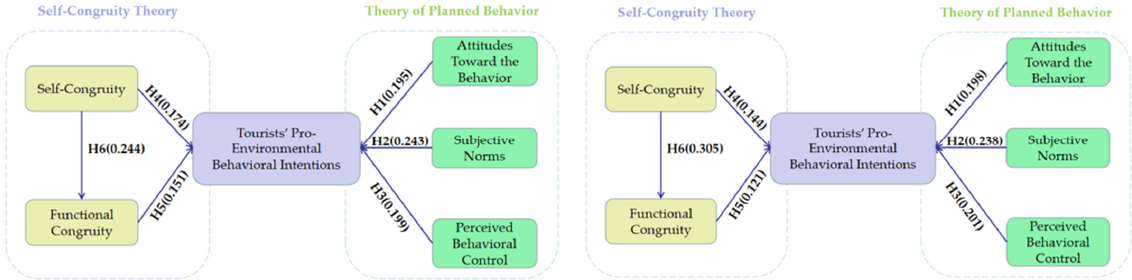
Figure 3. AMOS output results in the heritage destination ( left ) and the historic cultural destination